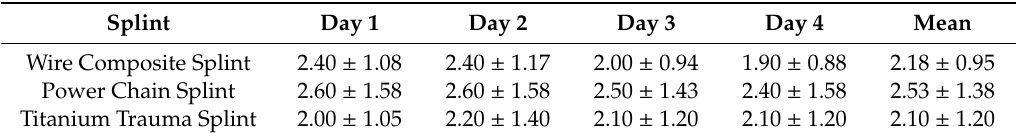
Table 6. Impairment of the oral hygiene.